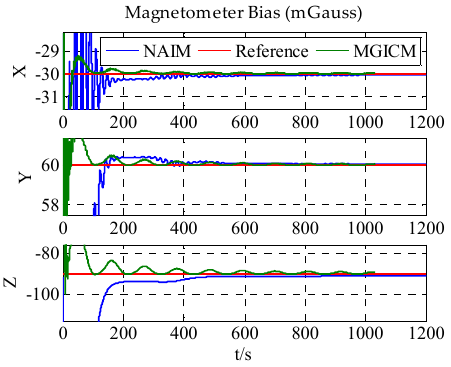
Figure 4 . Estimation result of magnetometer bias. MGICM: magnetometer and gyroscope integrated calibration method; NAIM: normal attitude-independent method.